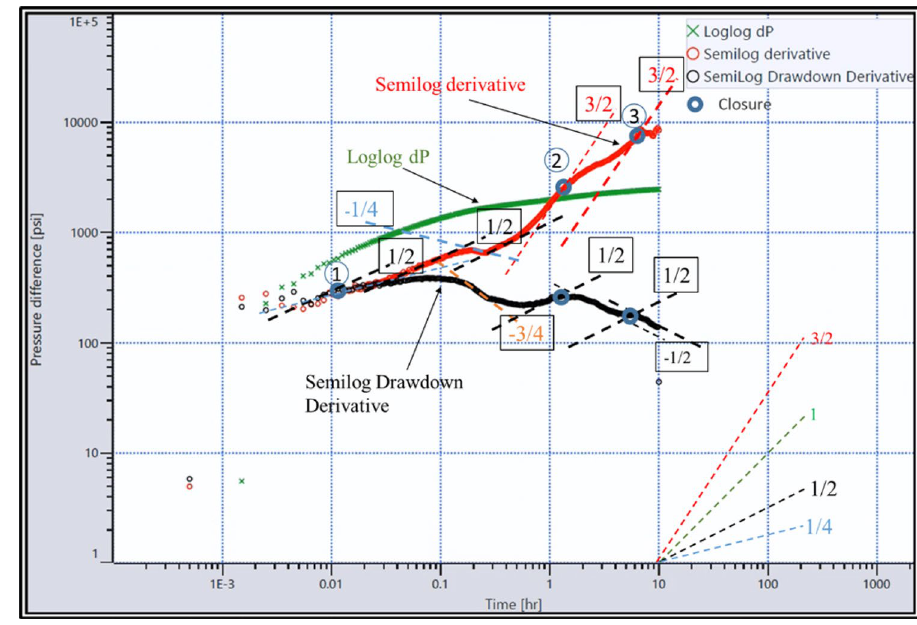
Fig. 13 Log–log diagnostic plot for Cycle #5 with multi-closure events. After tip extension and a couple of PDLs in early time, there are 3 closure events. The ½ slope is repetitive of fracture linear flow. Drawdown derivative is (∆ t d∆ P /d∆ t ), and